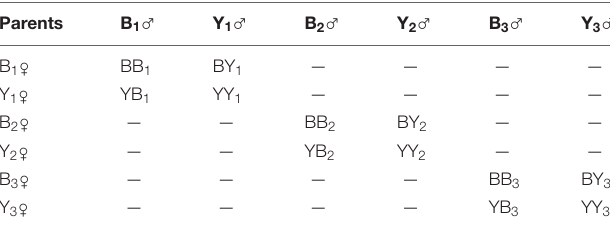
TABLE 1 | Experimental design for the crossbreeding of the boring giant clam between the blue and yellow-green